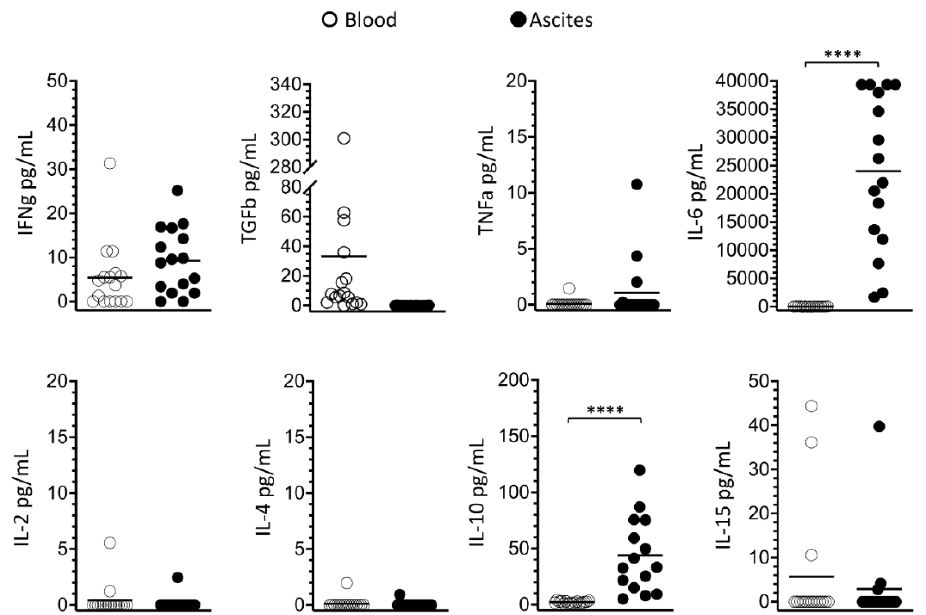
Figure 6. Comparison of soluble signaling molecules (IL-2, Il-4, IL-6, IL-10, IL15, IFNg, TNFa, TGFb) in blood (white circles) and ascites (black circles) of women with advanced EOC. Values are presented as percentages and mean. Statistical analyses were performed by unpaired two-tailed Student’s t -test, and p -values (**** p < 0.0001) indicate significant statistical differences.